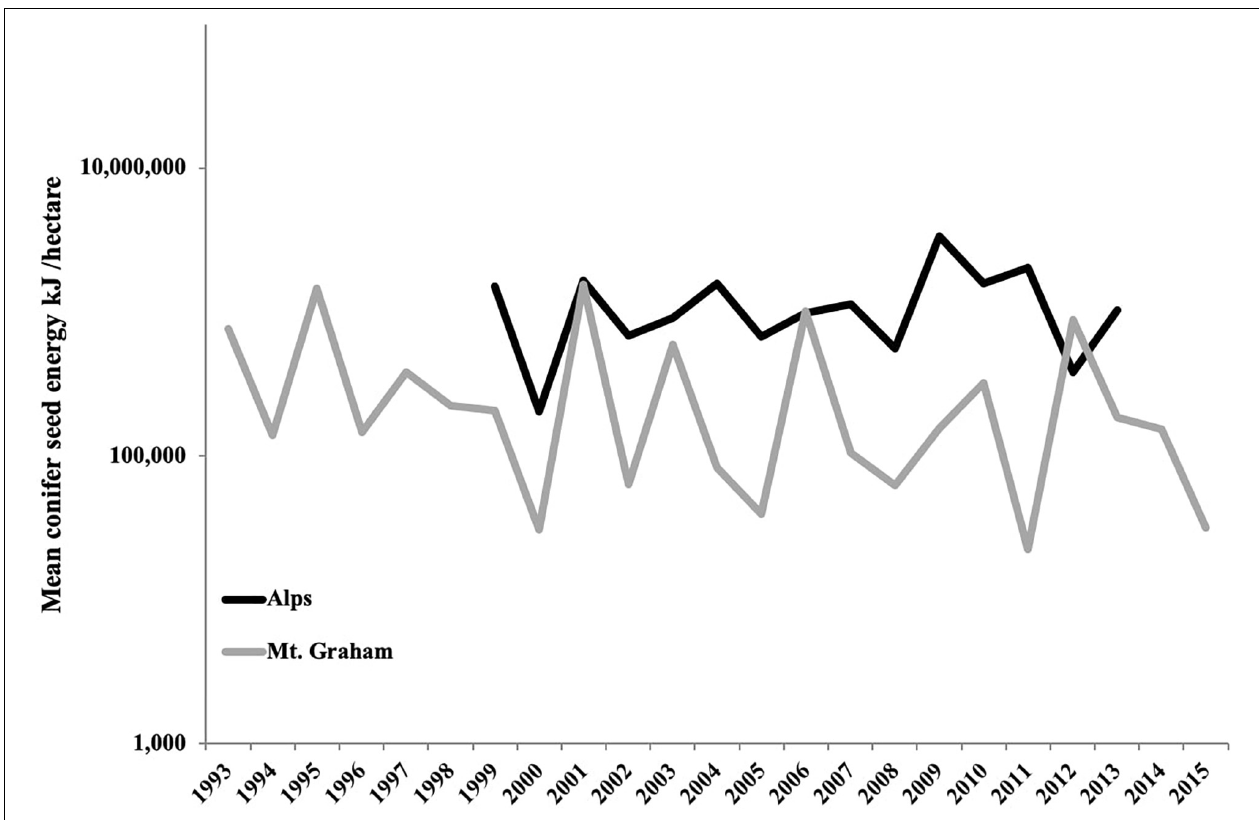
FIGURE 2 | Mean annual conifer seed production across study areas in the Alps (Lombardy, Italy: black line) and on Mt. Graham (Pinaleño Mountains, Arizona, the United States: gray line) expressed in kJ/ha. Seed energy is a measure of food resources available to Eurasian red squirrels ( Sciurus vulgaris ) and Mt. Graham red squirrels ( Tamiasciurus fremonti grahamensis ), respectively each year. More details provided in SM 1.2–1.3